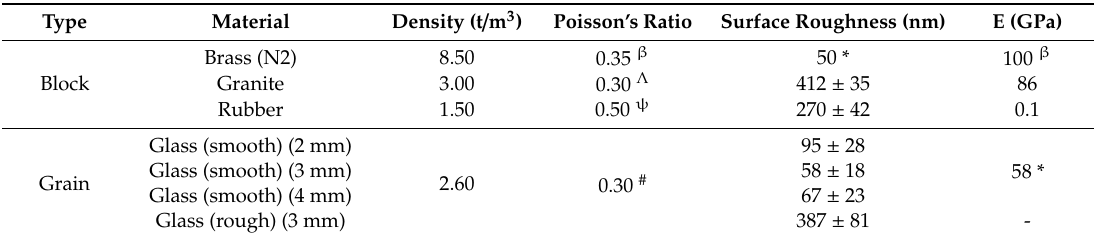
Table 1. Summary of material properties for the grains and blocks used in the impact